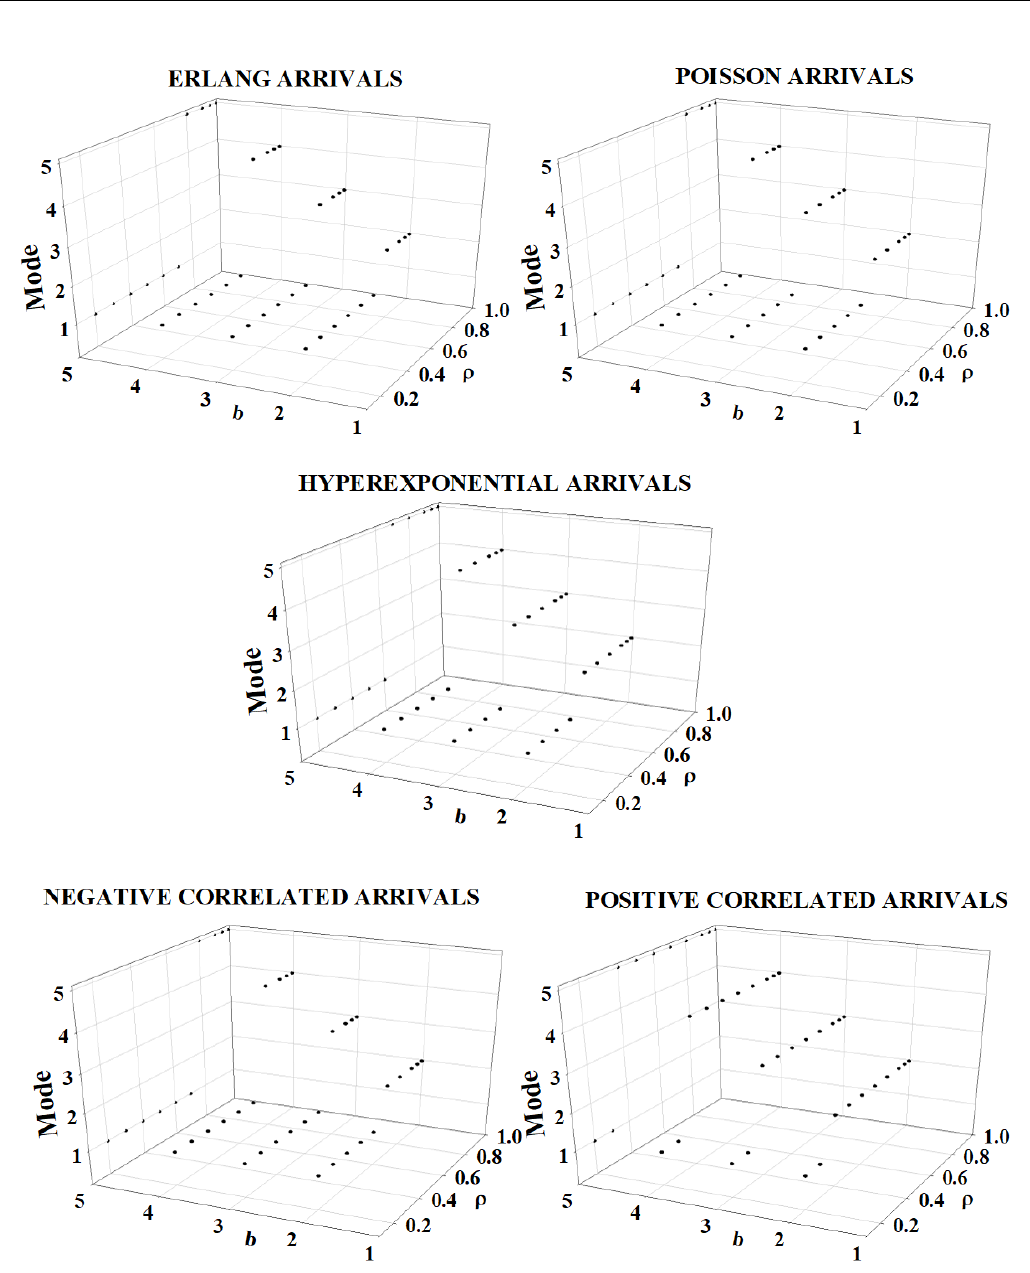
Figure 12. Scatter plot of the mode of the PMF of number in service for example